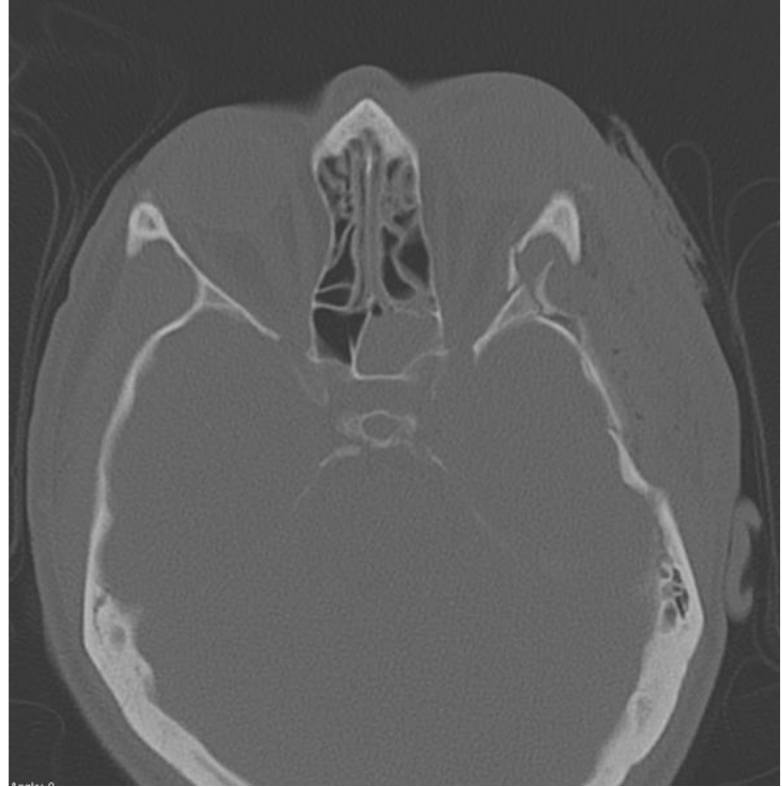
Figure 9. Trauma CT in an axial scan with visible temporal bone fractures.